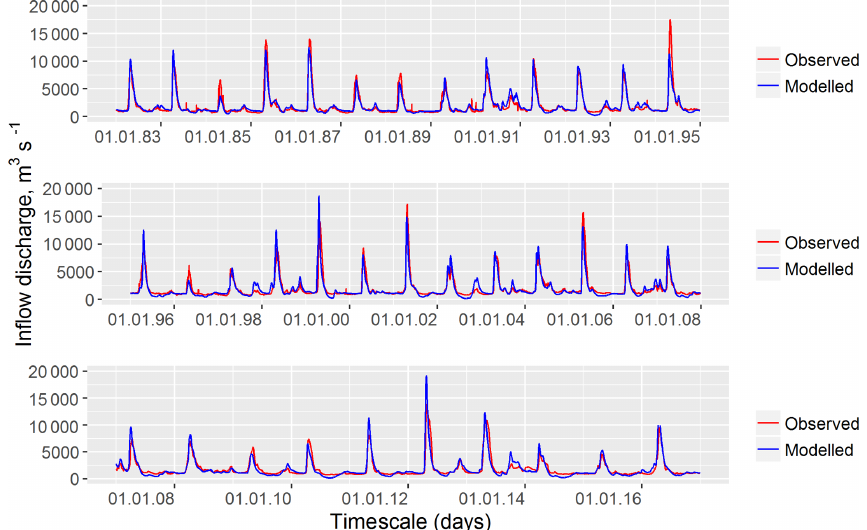
Figure 2. Observed and simulated daily discharges of inflows into the Cheboksary Reservoir.